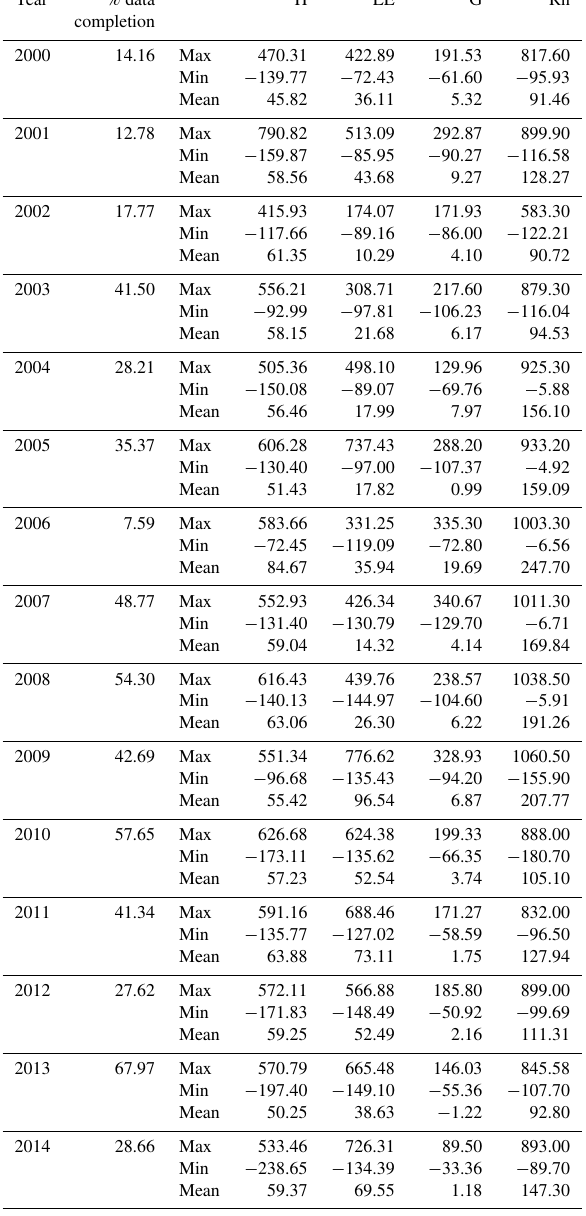
Table 2. Statistical summary of annual values of the energy balance